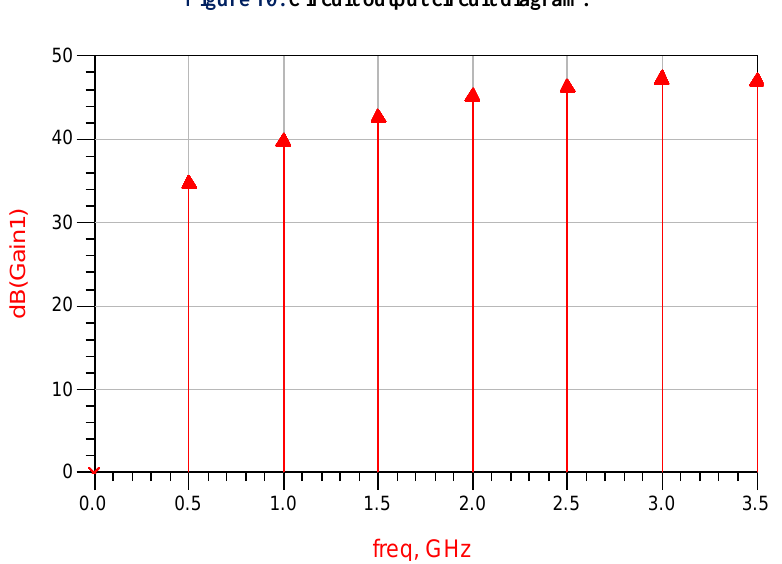
Figure 10. Circuit output circuit diagram.